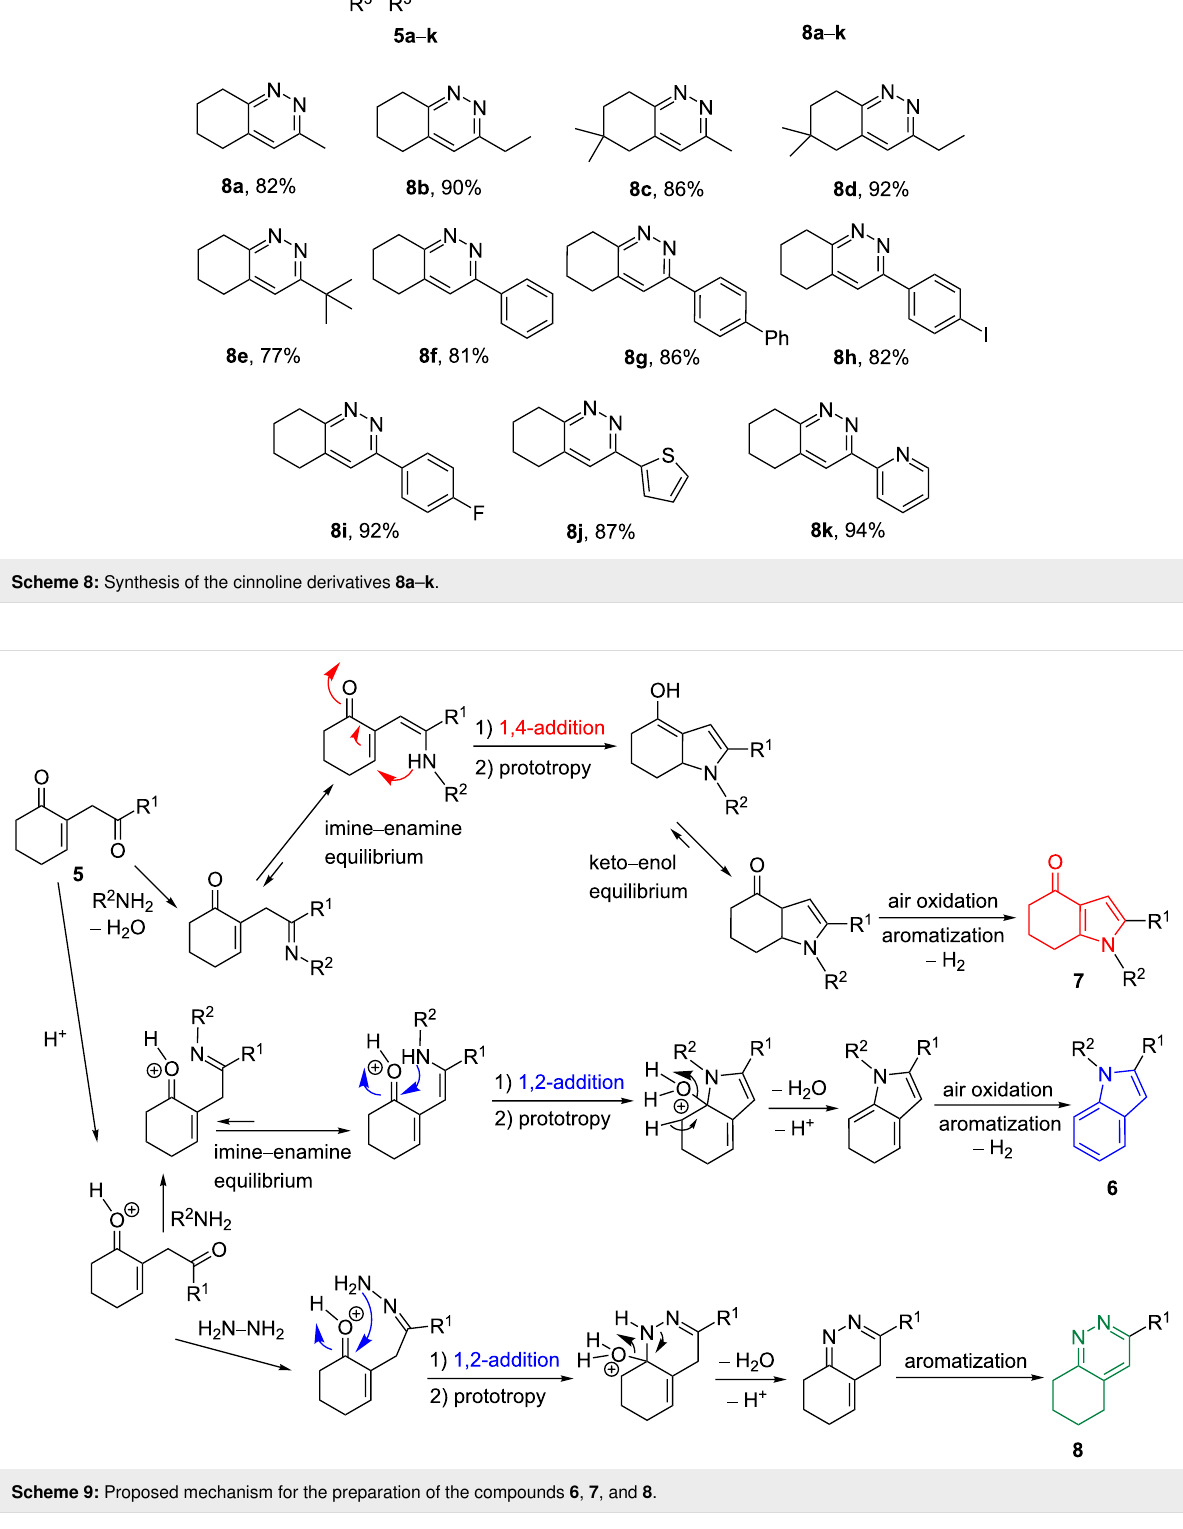
Scheme 9: Proposed mechanism for the preparation of the compounds 6 , 7 , and 8